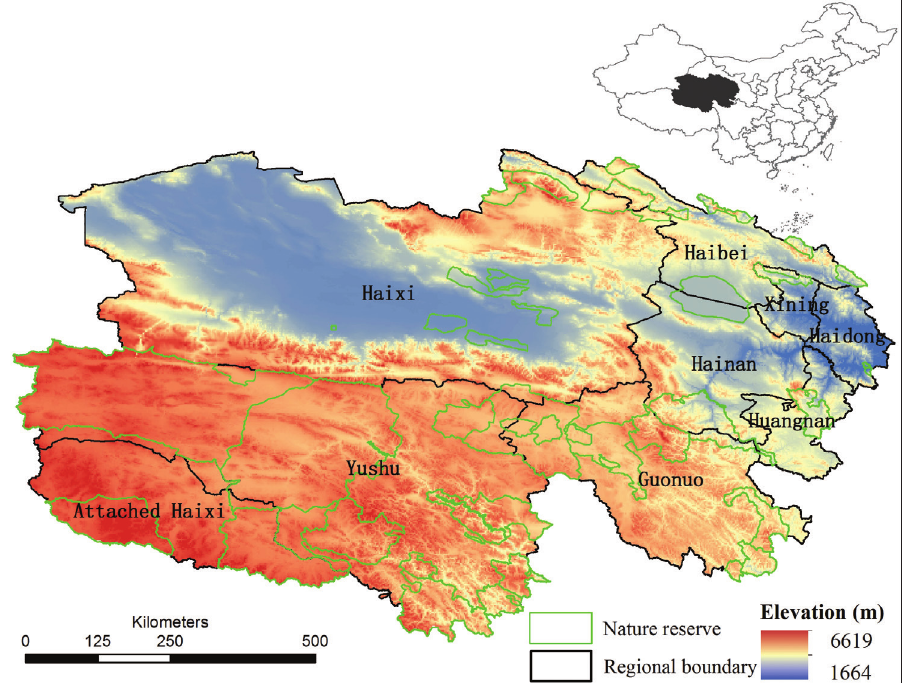
Figure 1. The location of Qinghai Province in China and the elevation